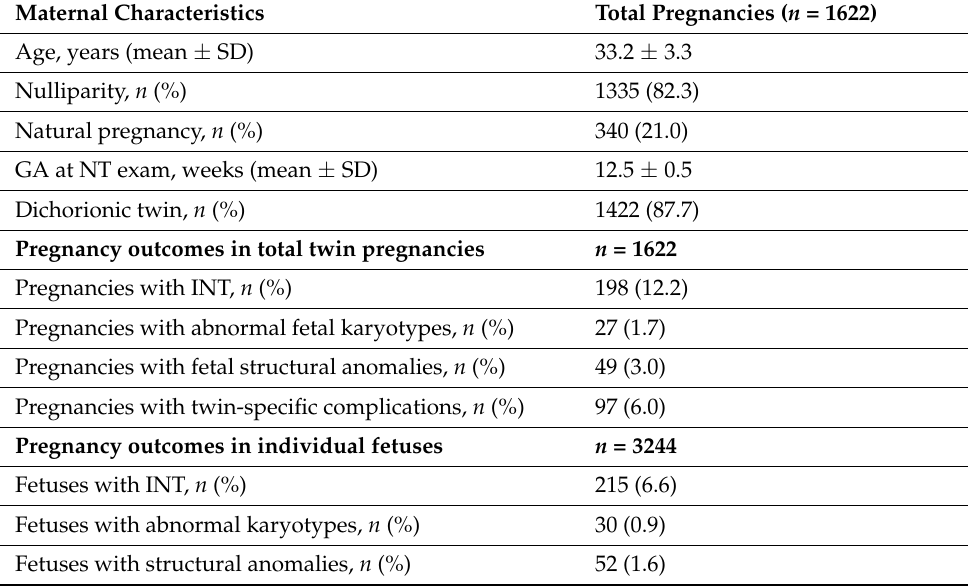
Table 1. Demographic characteristics and pregnancy outcomes in all twin pregnancies ( n = 1622) and individual fetuses ( n =